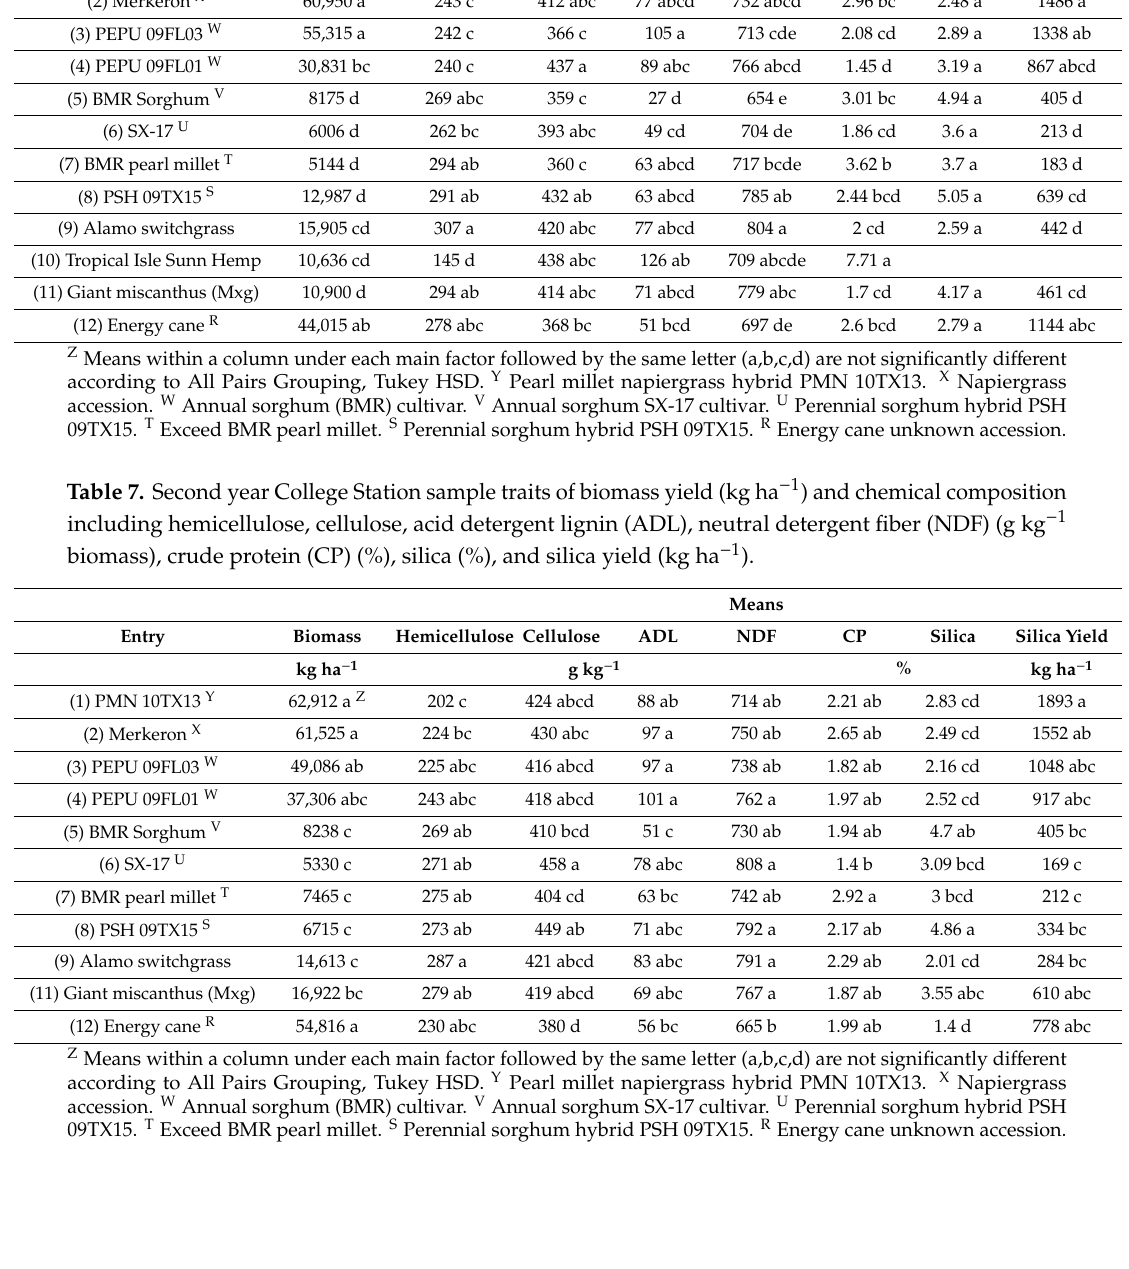
Table 6. Second year Stephenville sample traits of biomass yield (kg ha − 1 ) and chemical composition including hemicellulose, cellulose, acid detergent lignin (ADL), neutral detergent fiber (NDF) (g kg − 1 biomass), crude protein (CP) (%), silica (%), and silica yield (kg ha − 1 ). Means Entry Biomass Hemicellulose Cellulose ADL NDF CP Silica Silica Yield kg ha − 1 g kg − 1 % kg ha − 1 (1) PMN 10TX13 Y 17,226 cd Z 270 abc